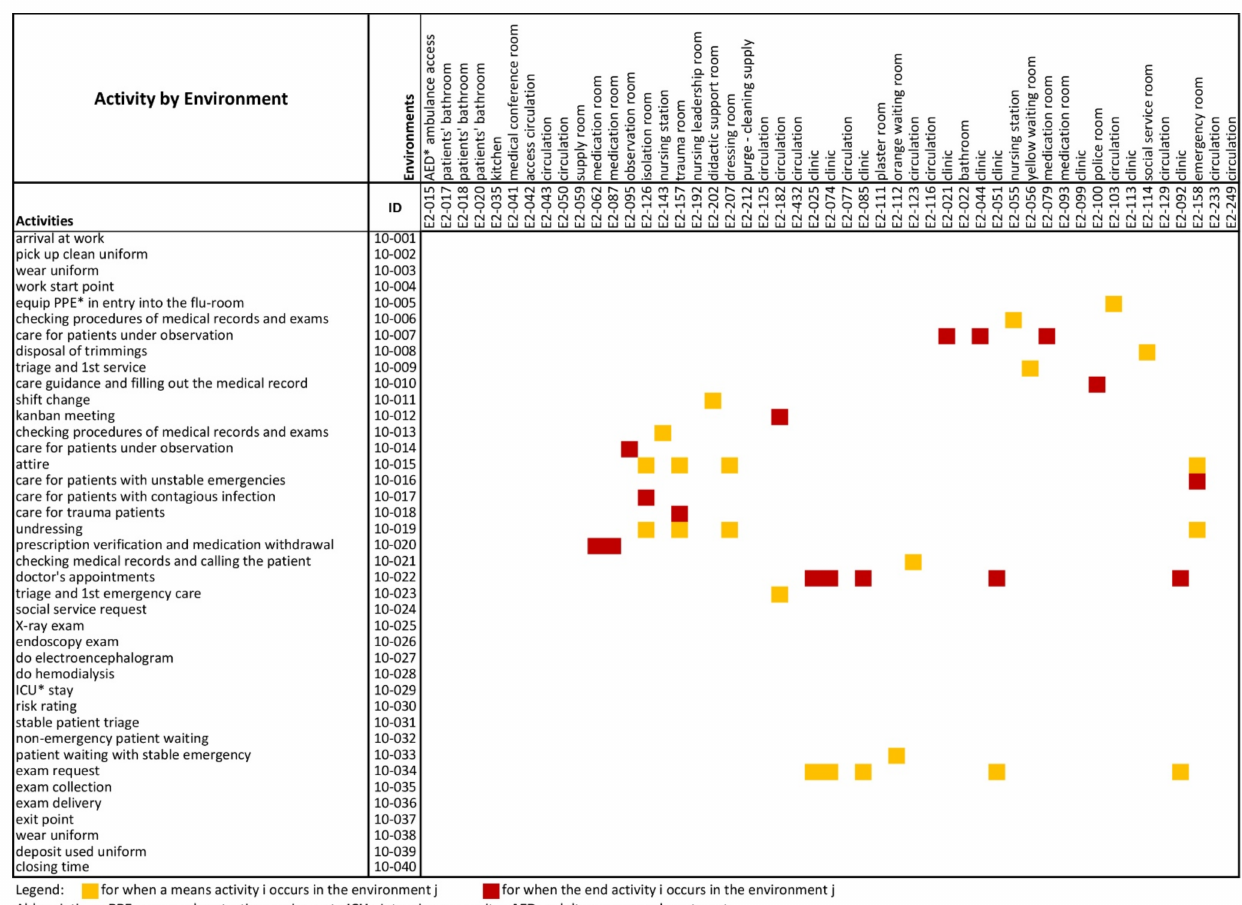
Figure 6. Detailed relationship matrix ( R mn ) of the medical activities in AED (see full matrix in